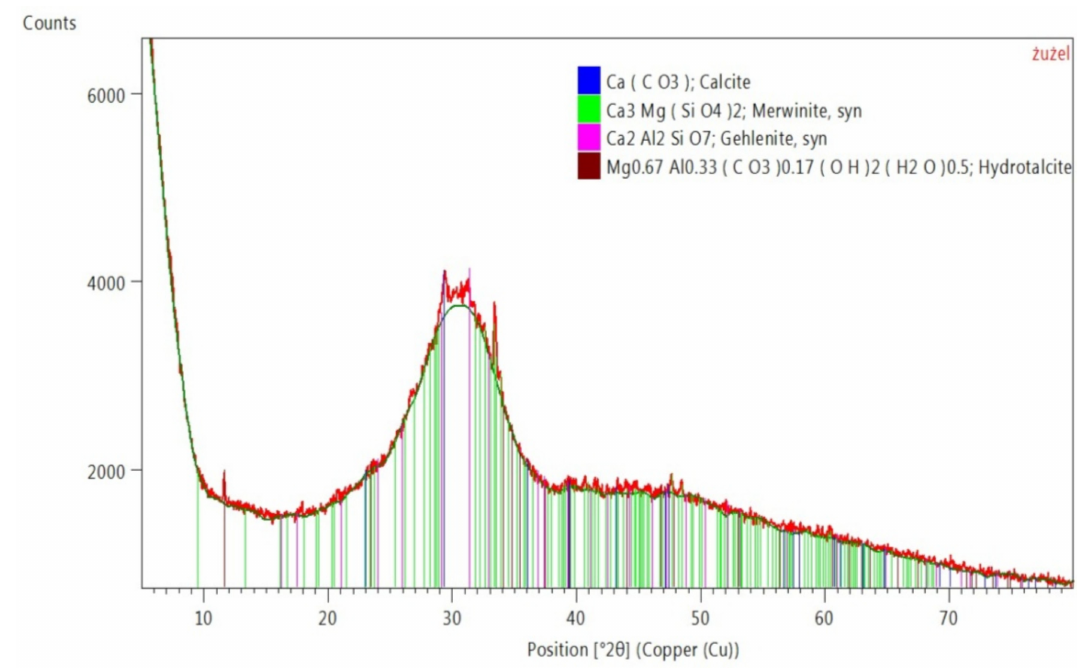
Figure 6. Phase composition of GGBFS.